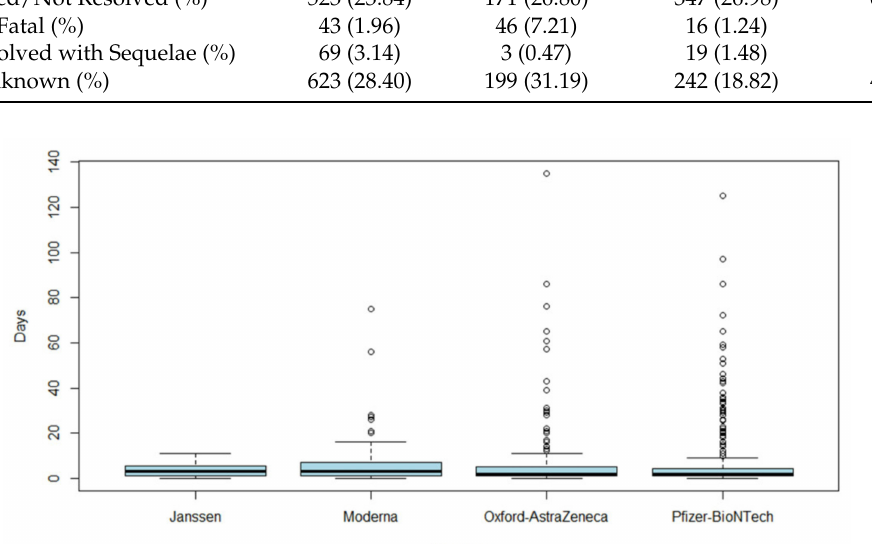
Figure 2. Time for impaired glucose metabolism events. Boxplots of duration of all impaired